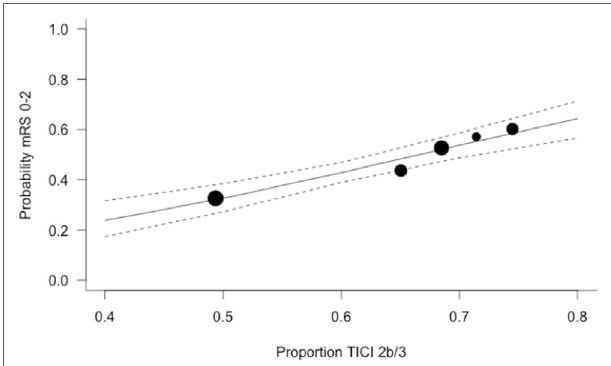
FigUre 2 | Predicted probability of modified Rankin Scale score 0–2 by modified thrombolysis in cerebral ischemia grade 2b/3, with dashed line showing 95% CI, and size of markers inversely proportional to each within-trial SD (intention-to-treat analysis).